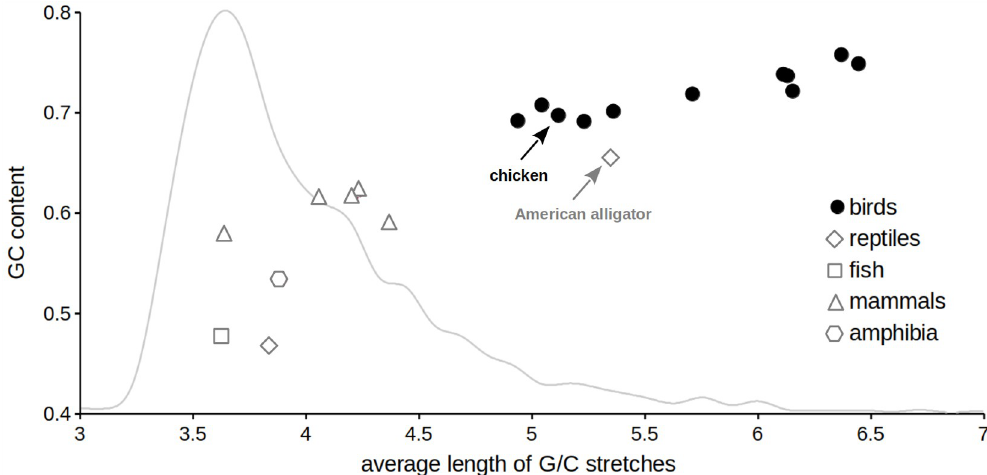
Fig 2. LAT gene exhibits a high GC content and long G/C stretches in birds. Comparison of GC content and the presence of G/C stretches in LAT genes from birds and other vertebrates. Dot plot was generated based on the coding sequences of LAT gene from vertebrate species shown in Fig 1. GC content is plotted against average length of sequence stretches containing G or C nucleotides. G/C-stretch was defined as an undisrupted sequence of at least three consecutive G or C nucleotides [18]. To allow comparison with all annotated chicken genes, a histogram showing the distribution of average G/ C-stretch length in the chicken RefSeq gene category is depicted by a gray line. Chicken RefSeq genes comprise the complete set of approximately six thousand chicken coding sequences longer than 299 nucleotides. The chicken ( Gallus gallus ) and American alligator ( Alligator mississippiensis ), which is the closest relative to birds from included reptile species, are highlighted by